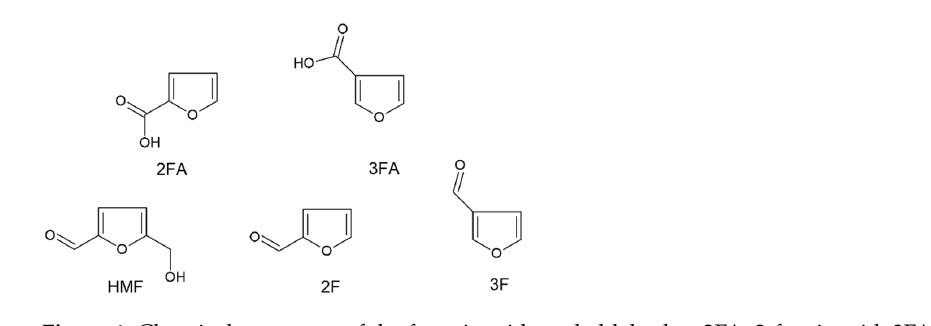
Figure 1. Chemical structures of the furanic acids and aldehydes. 2FA, 2-furoic acid; 3FA, 3-furoic acid; HMF, hydroxymethylfurfural; 2F, 2-furaldehyde; 3F, 3-furaldehyde.